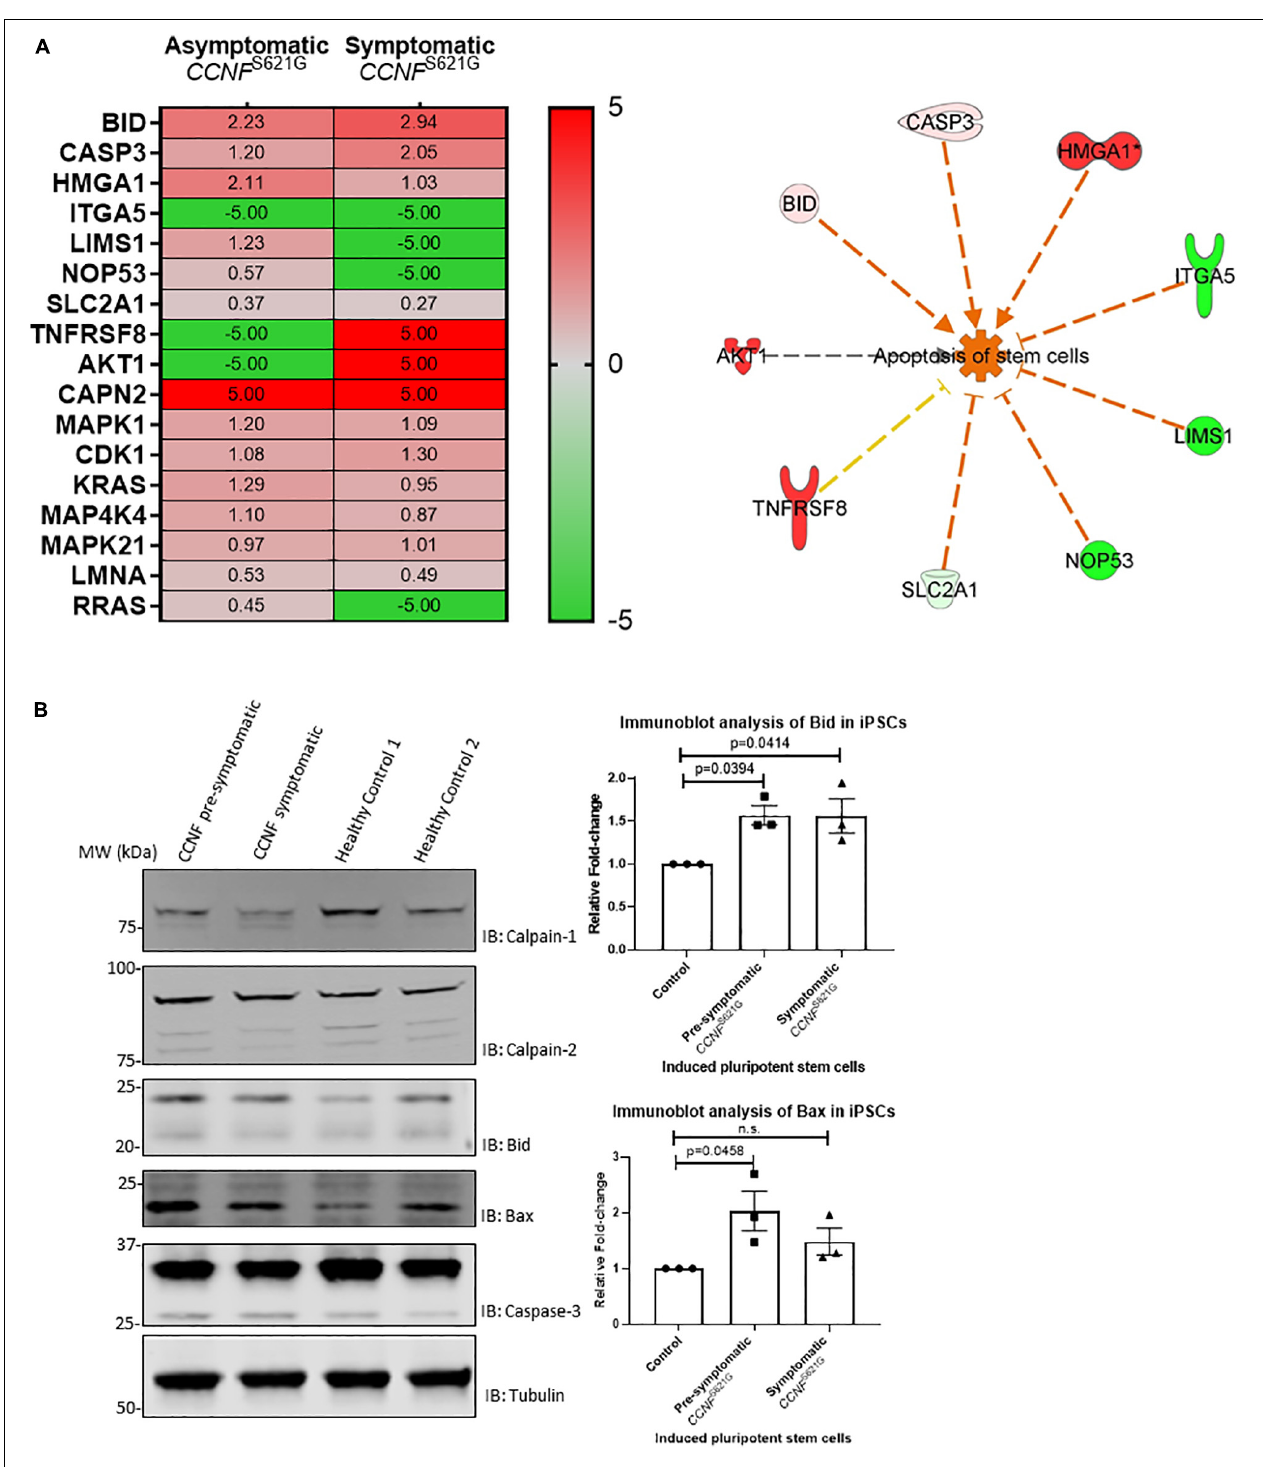
FIGURE 5 | (A) iPSCs from asymptomatic and symptomatic ALS patients harboring the CCNF S621G mutation were subjected to global proteomics analysis. IPA of the quantitative proteomics data predicted activation of the apoptosis pathway. Red and green annotations refer, respectively, to experimentally measured values. Orange and blue annotations and lines refer, respectively, to predicted activation and inhibition as determined by IPA. Dashed lines indicate an indirect causal relationship (log2 values shown; values shown as 5 and − 5, respectively, indicate detection of the presence and absence of a protein and are not measured values). (B) Immunoblot analysis of iPSCs from asymptomatic and symptomatic ALS patients harboring the CCNF S621G mutation compared to healthy controls reveals increased expression of pro-apoptotic proteins Bid and Bax. One-way ANOVA with Dunnett’s multiple comparison test ( n =